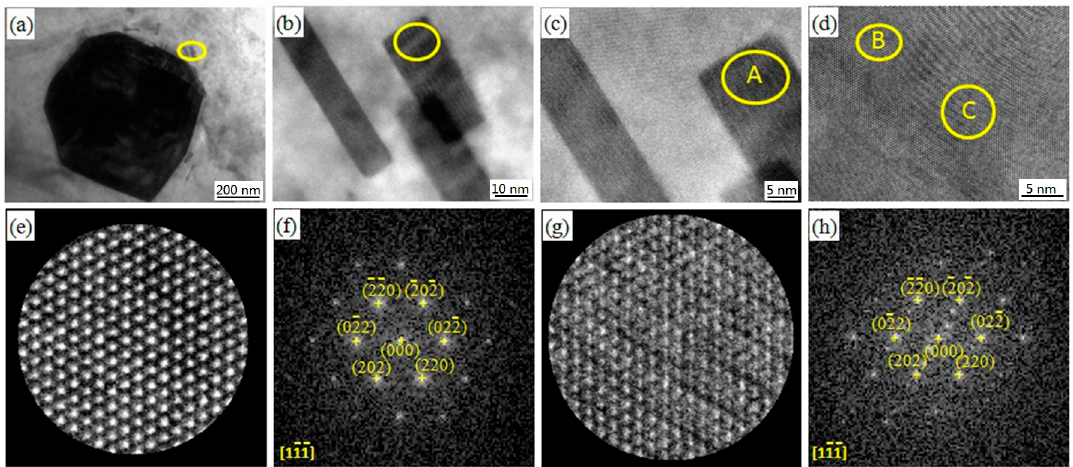
Figure 4. TEM images of the 3Gd alloy: ( a – c ) BF TEM image; ( d ) HRTEM image; ( e ) HRTEM image of the B zone; ( f ) FFT image of ( e ); ( g ) HRTEM image of the C zone; ( h ) FFT image of ( g ).